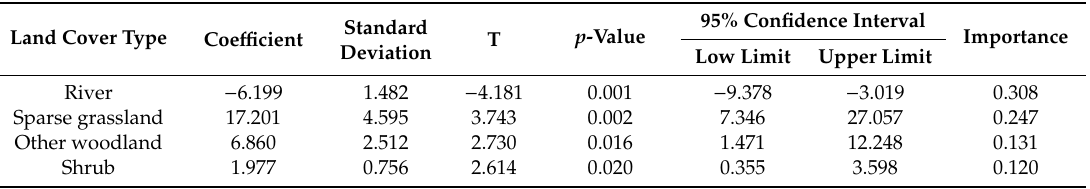
Table 4. Importance of changes in land cover types on soil erosion.